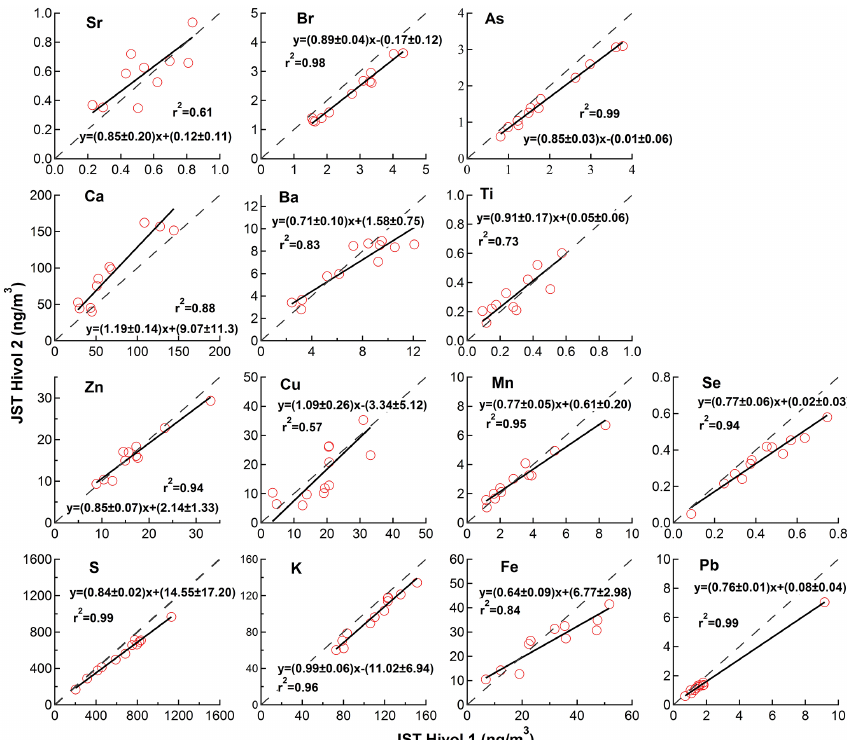
Figure 4. Precision from collocated measurements assessed by filter samples ( N = 11) collected simultaneously using two Hi-Vol samplers deployed at JST during November 2012 (analysis was done by orthogonal regression; the dotted line is 1 :